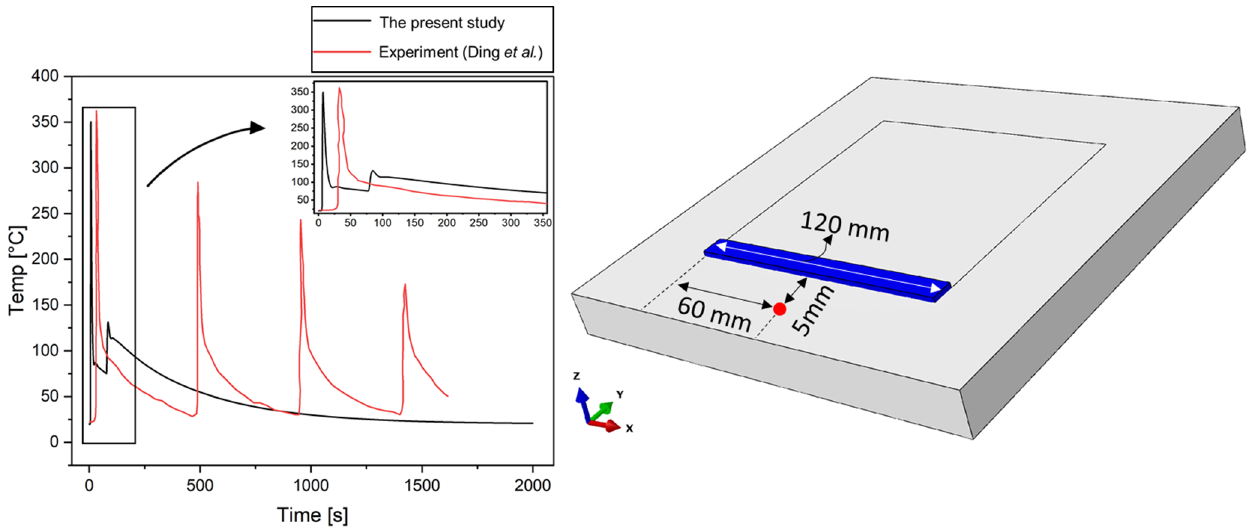
Figure 5. Verification of the current temperature calculations at the point 5 mm away from the deposition path compared with the experimental measurements.